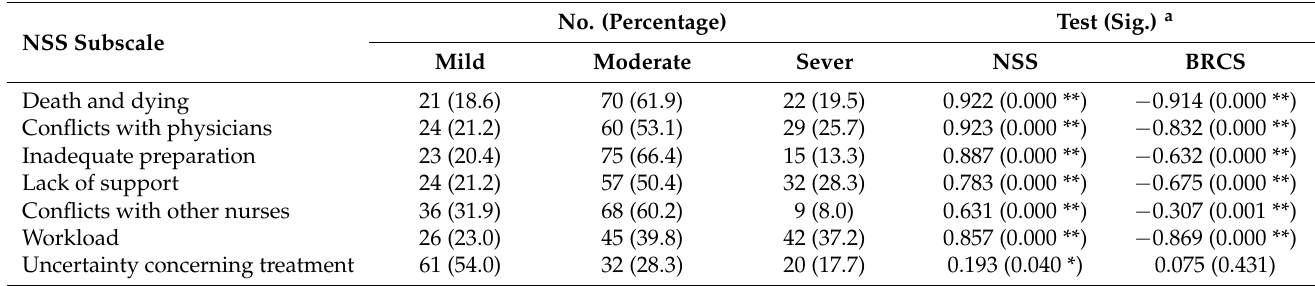
Table 3. Nursing Stress Scale Subscales Score and Correlation with Total Score and Brief Resilient Coping Scale.